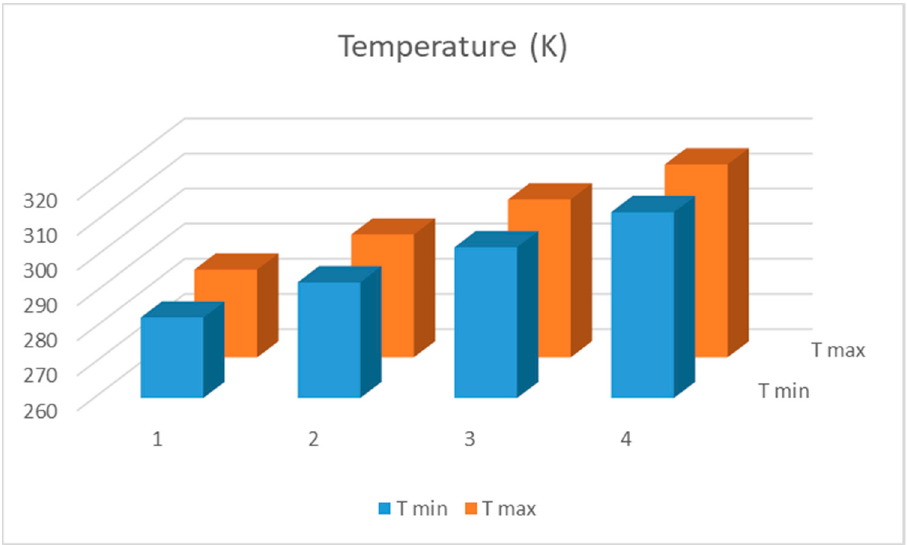
Figure 7. Maximum and minimum temperature of cooling plate.